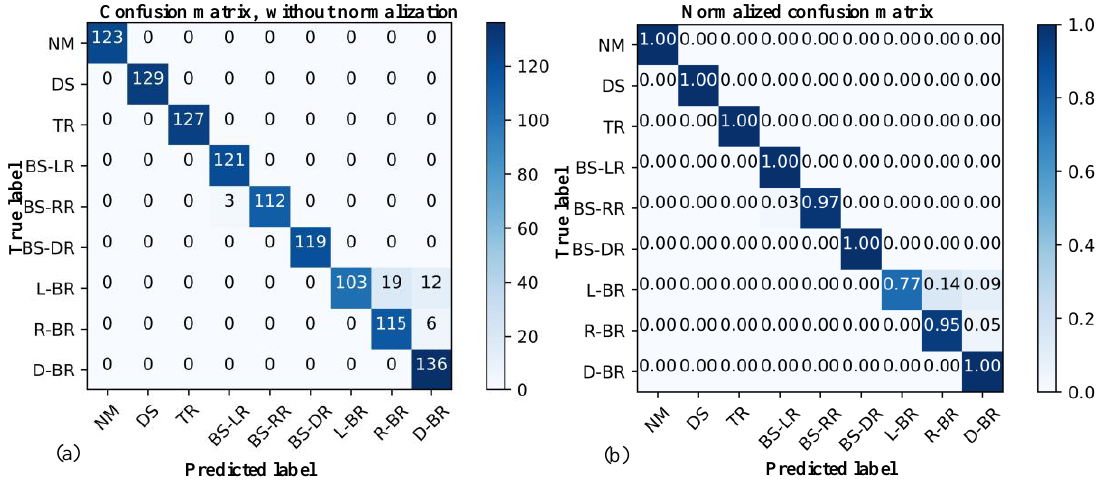
Figure 16. The confusion matrices of ANN-BP. ( a ) Without normalization; ( b ) normalized.